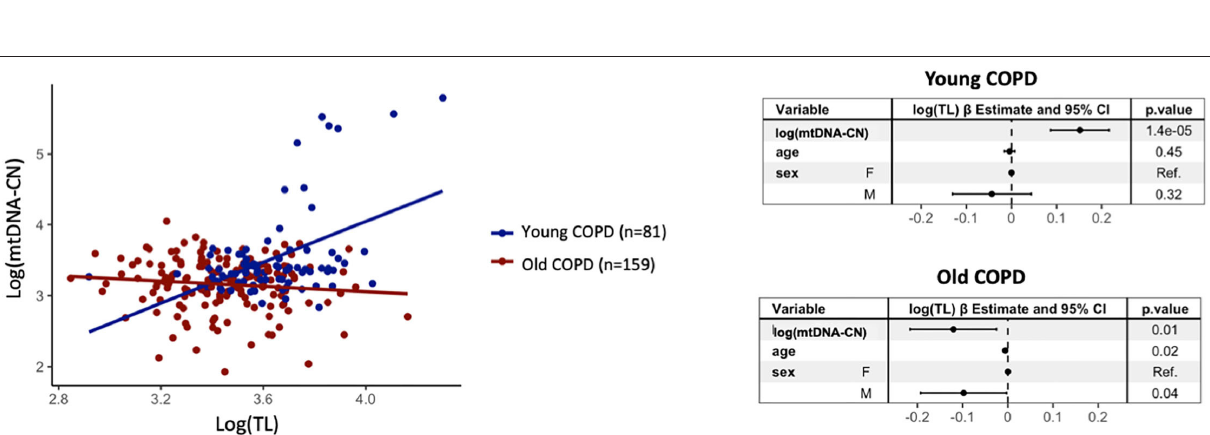
Frontiers in Medicine |